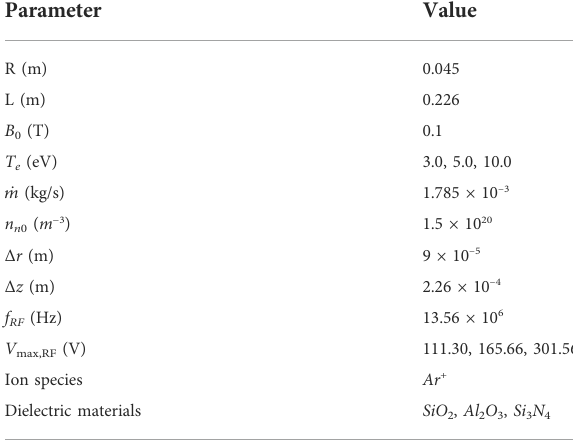
TABLE 5 Geometrical and physical parameters used for the simulation results ofthe VX-CRdevicepresentedinSection3.2.Thevaluesof T e and V max,RF correspond to three separate scenarios, and were obtained from the regression described in Figure 7. Parameter